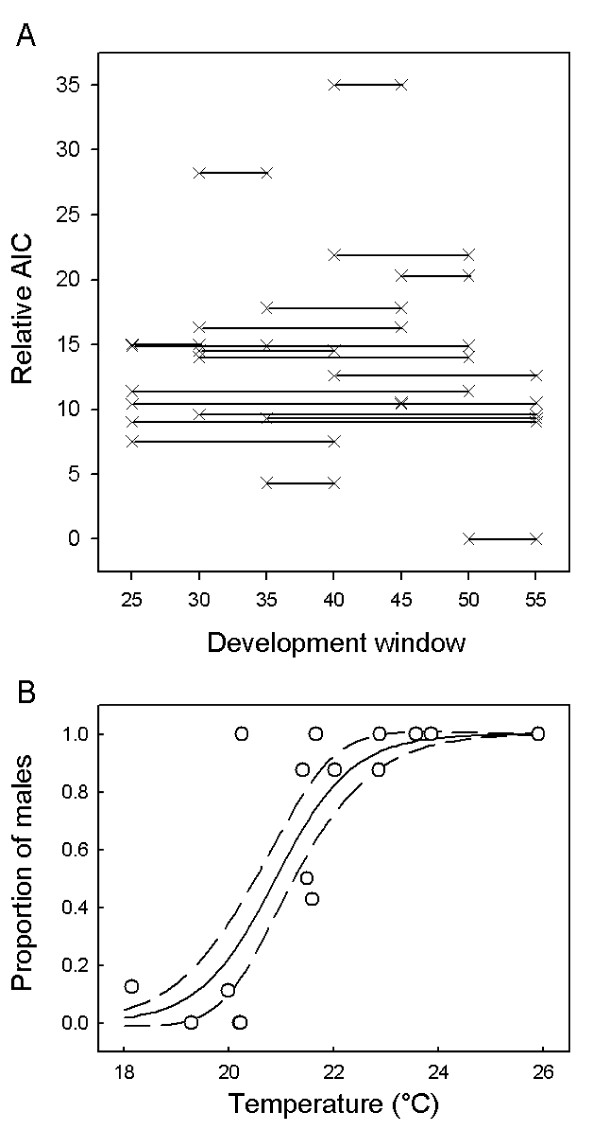
A. Relative AIC over different development windows, using TSD model type FM logistic. The period 0.50–0.55 has the lowest AIC (relative AIC set to zero). Generally development windows including 0.50–0.55 have low AIC. B. Example showing the relationship between the CTE (0.50–0.55) in natural nests and the hatchling sex ratio. The curve (—) is the maximum likelihood fit, and dashed lines are ± 2 SE.